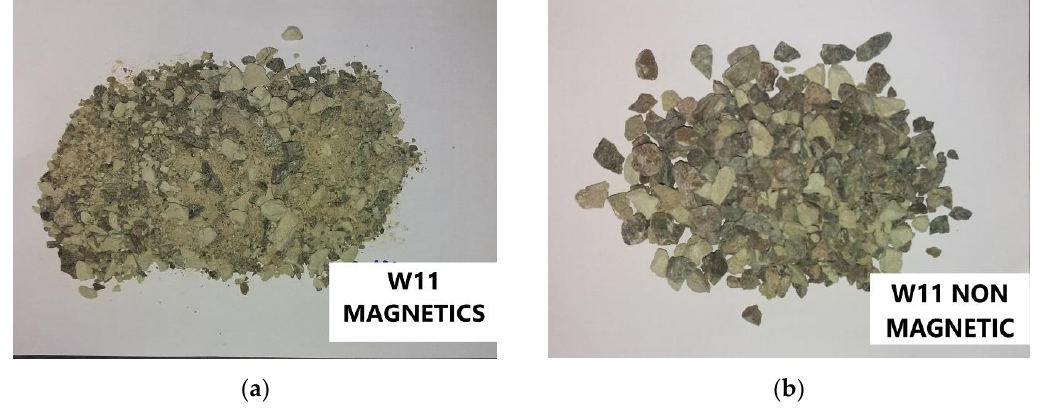
Figure 1. The sample W11 fractions after the application of magnetic separation: ( a ) magnetic fraction; ( b ) non-magnetic fraction. Table 3. Chemical analysis using XRF and LoI of magnetic and non-magnetic fractions. Sample